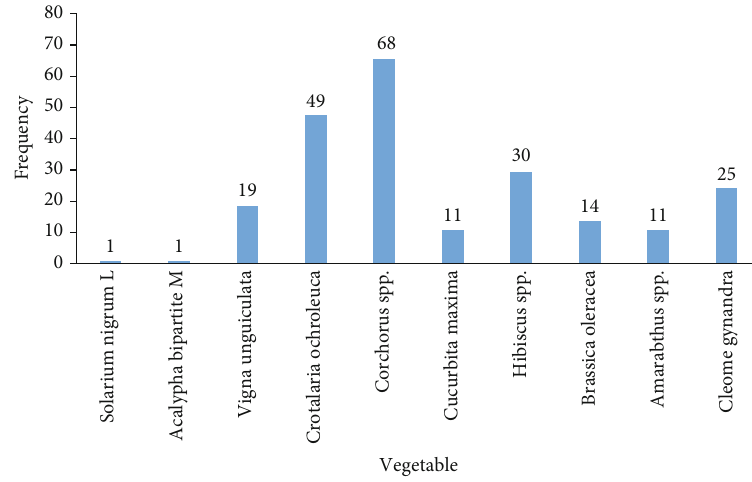
Figure 3: The most e ff ective medicinal vegetables in Northern Uganda.